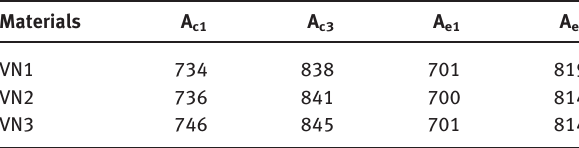
Table 2: Phase transformation temperatures